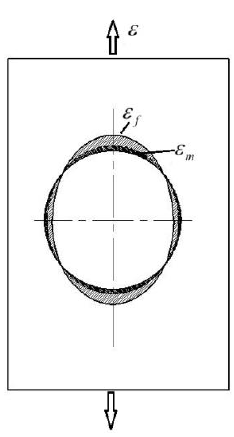
Figure 3. Mismatch of deformation along the particle boundary.